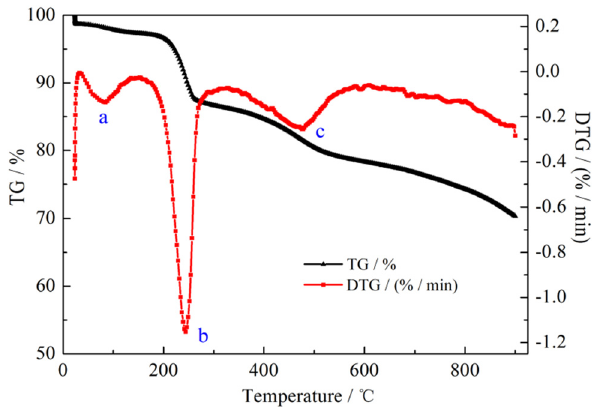
Figure 2: TG – DTG curve of the mixture of Li 2 CO 3 , Ni 0.8 Co 0.15 ( OH ) 1.9 , and Al ( NO 3 ) 3 · 9H 2